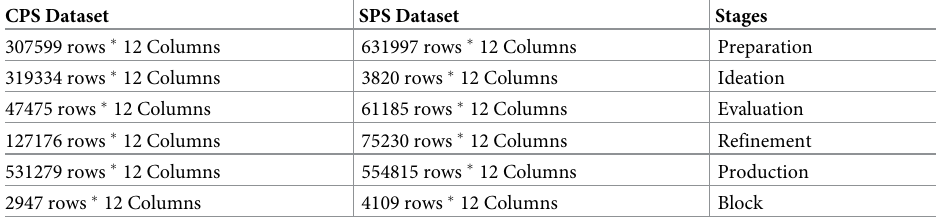
Table 2. CPS and SPS datasets of labelled in six stages (rows) and 12 AUs (columns) for all participants, used for the SVM